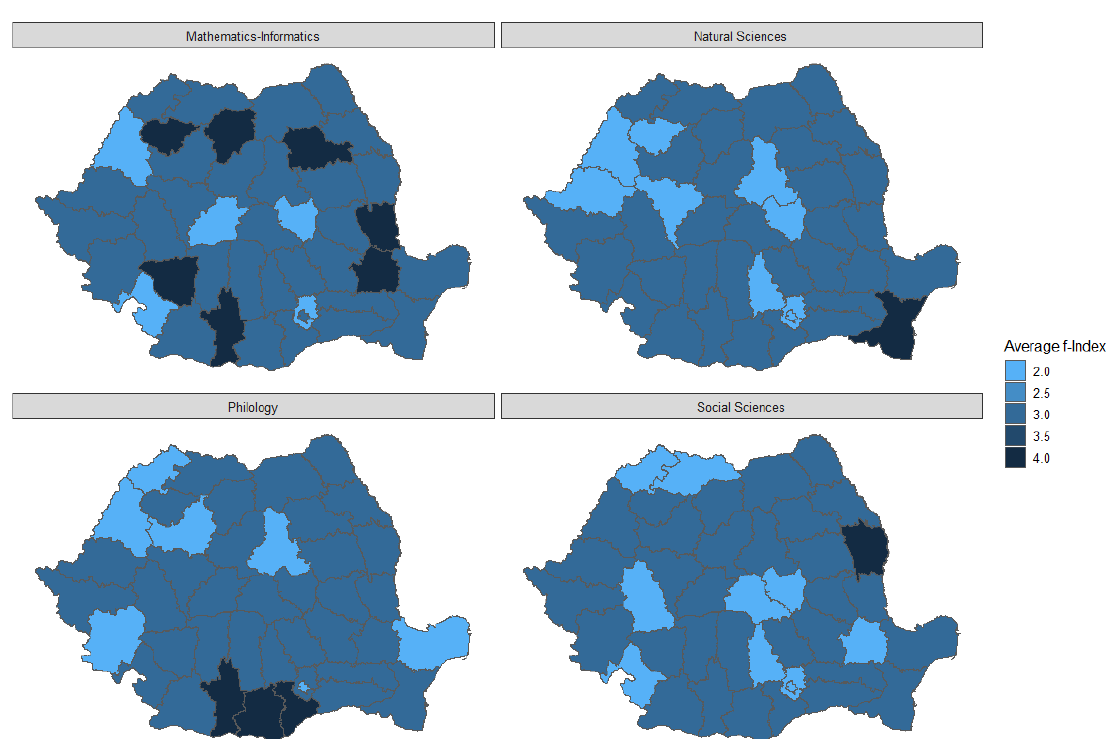
Figure 6. Average f -index by specialisation.